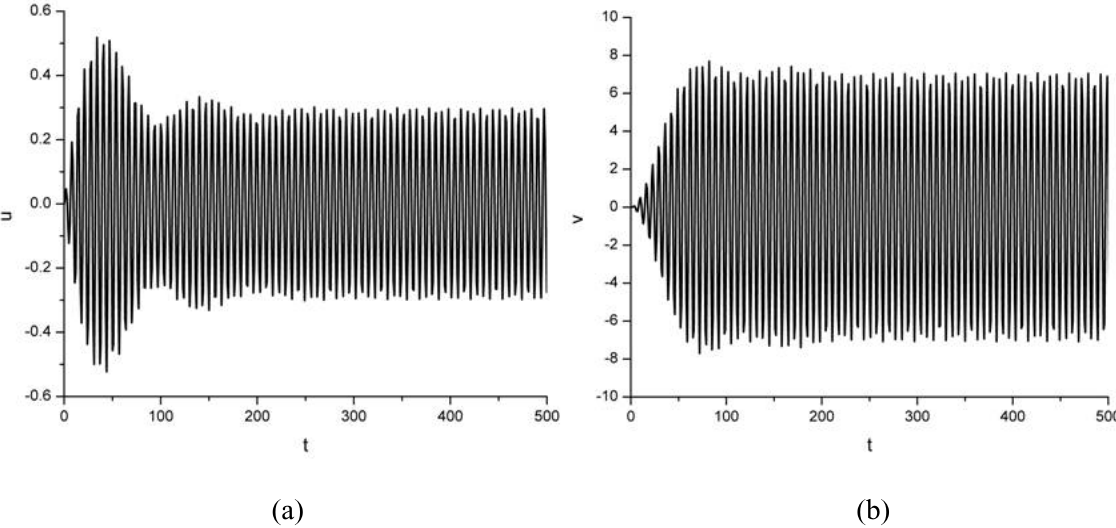
Fig. 18. Numerical simulation of the time response of (a) the plant and (b) the absorber when ω 2 = 0 . 95 , Ω = 0 . 95 and G = 0 . 002 .